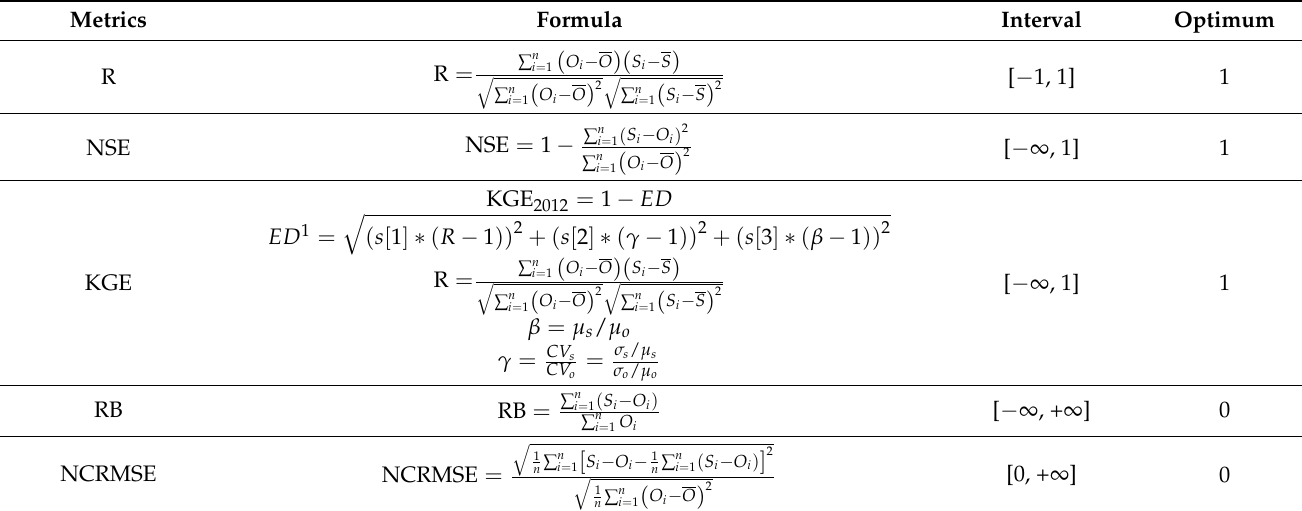
Table 2. Performance metrics used in this